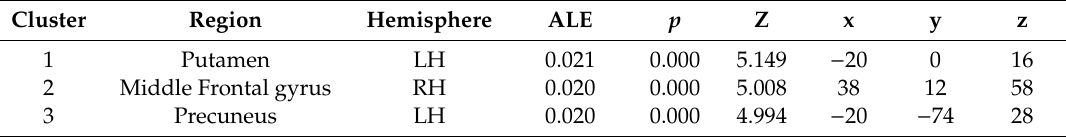
Table 3. Results of ALE meta-analysis on activation in Gambling Disorder. For each cluster region Table 4. Results of ALE meta-analysis on activation in Alcohol Use Disorder. For each cluster region label, the hemisphere, ALE value, p and z values, and MNI coordinates are provided. LH = left label hemisphere, the cluster size (mm 3 ), ALE value, and MNI coordinates are provided. LH = left hemisphere; RH = right hemisphere. hemisphere; RH = right hemisphere.